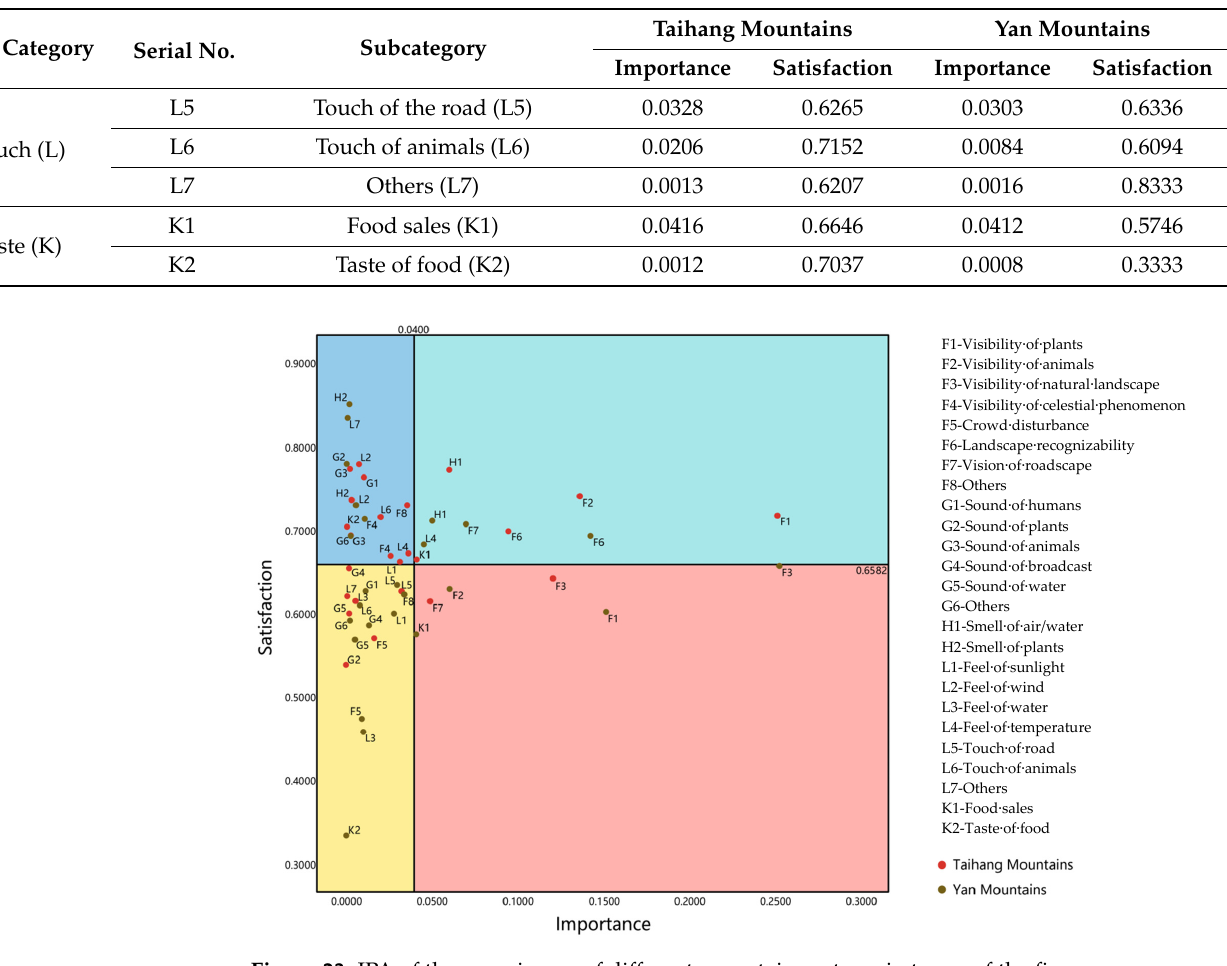
Figure 23. IPA of the experiences of different mountain systems in terms of the five senses.